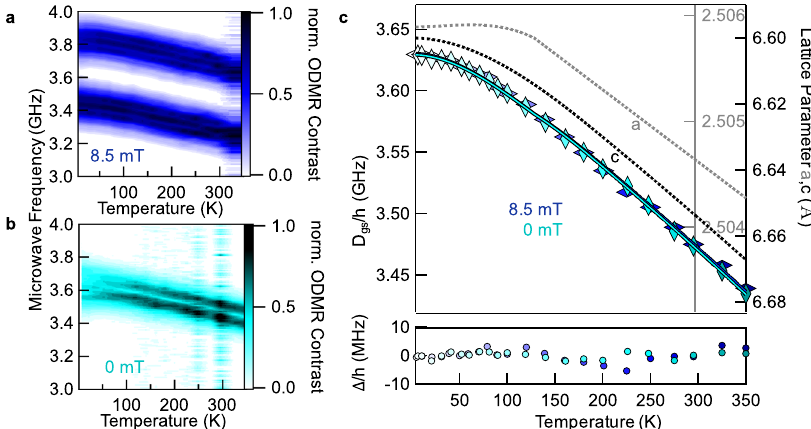
Fig. 2 Temperature dependence of the ODMR spectrum of V − B . Color maps represent the peak positions of the normalized ODMR spectrum for different temperatures in an external magnetic fi eld of a B = 8.5 mT and b B = 0 mT. c ZFS parameter D gs = h obtained from a (blue diamonds) and b (cyan diamonds) vs. temperature. The monotonic increase while lowering the sample temperature is unaffected by the magnetic fi eld. The data can be fi tted using Eq. (2) describing the temperature-dependent change of the lattice parameters a (gray dotted line 24 ) and c (black dotted line 24 ) that are also plotted in ( c ). The fi ts are shown as solid lines (blue for 8.5 mT and cyan for 0 mT) on top of the diamonds and reproduce the temperature dependence perfectly. (bottom panel) The difference between measurements and fi t ( Δ /h